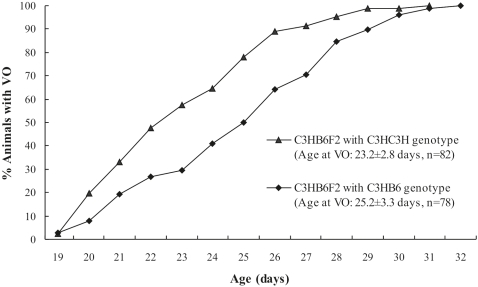
Comparison of the Timing of Vaginal Opening between different genotypes of DXMit166.The cumulative percentage of animals with vaginal opening (VO) is displayed. The distribution of age at VO of mice with different genotype at the peak linkage marker is shown.